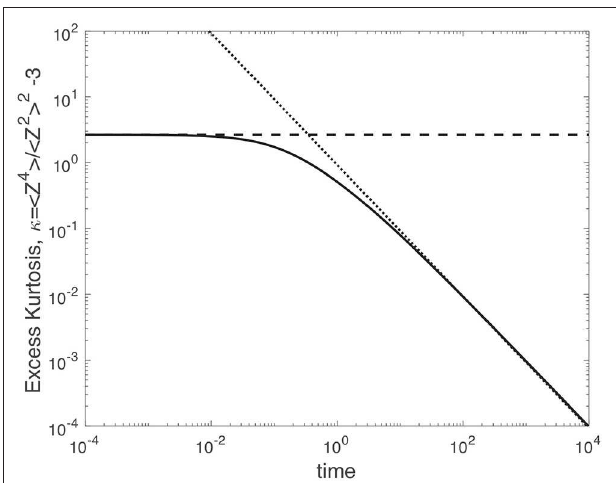
FIGURE 4 | The excess kurtosis κ vs. time for δ The dashed curve indicates the short-time behavior of the excess kurtosis based on our model for heterogeneity. The dotted curve gives the long-time relaxation of the excess kurtosis to zero.